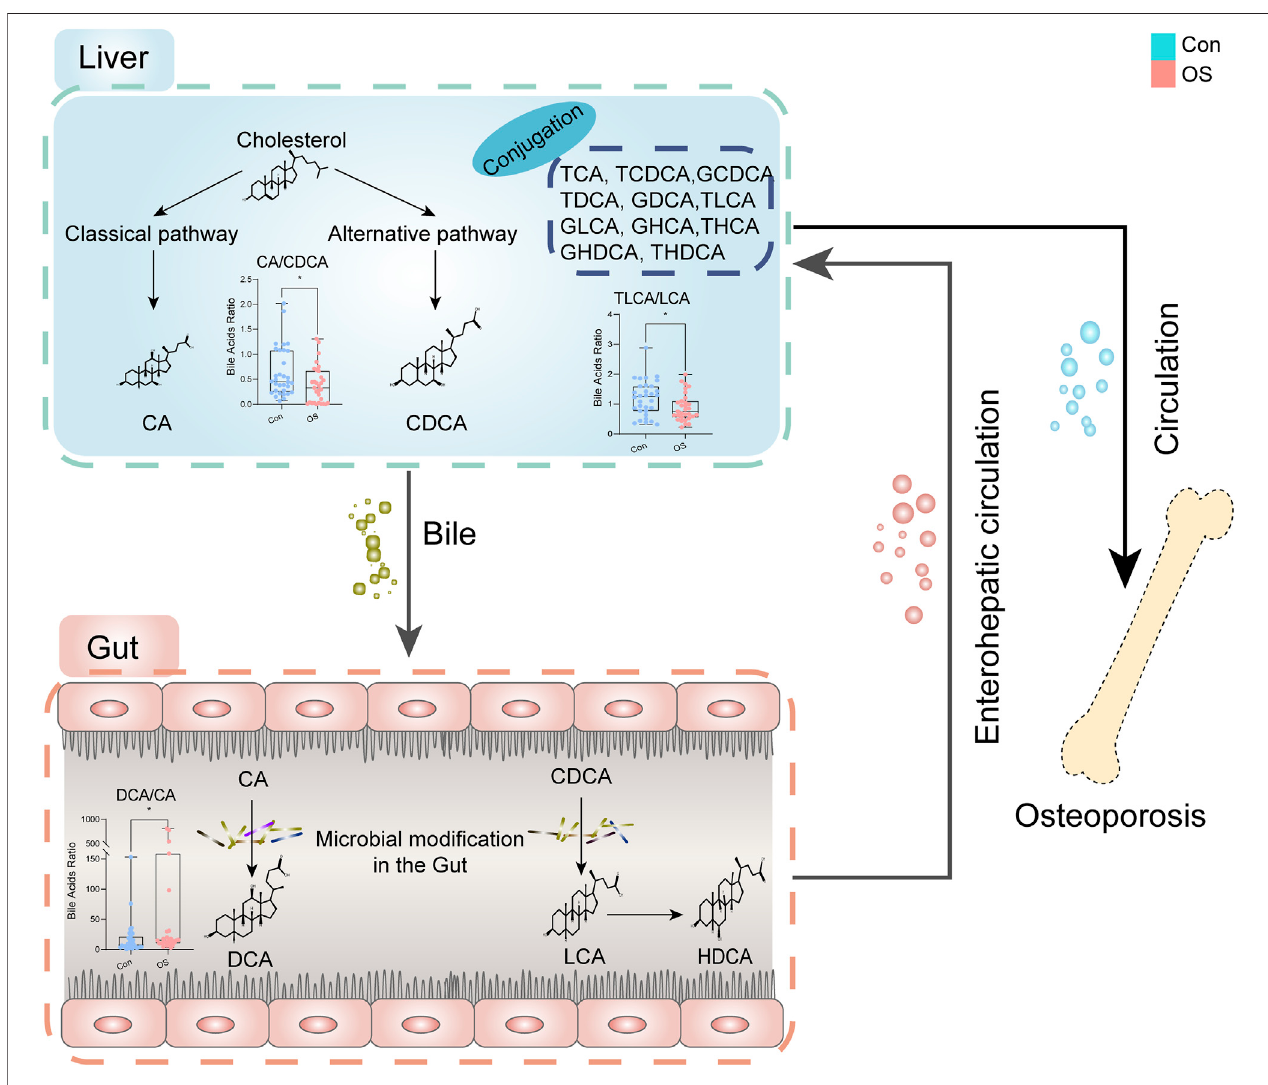
FIGURE 5 | Dysregulation of BA metabolism in